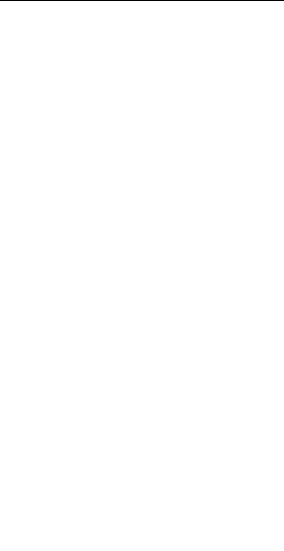
Figure 3. Share of substrates used for agricultural biogas production in 2018. Source: own elaboration based on [37].